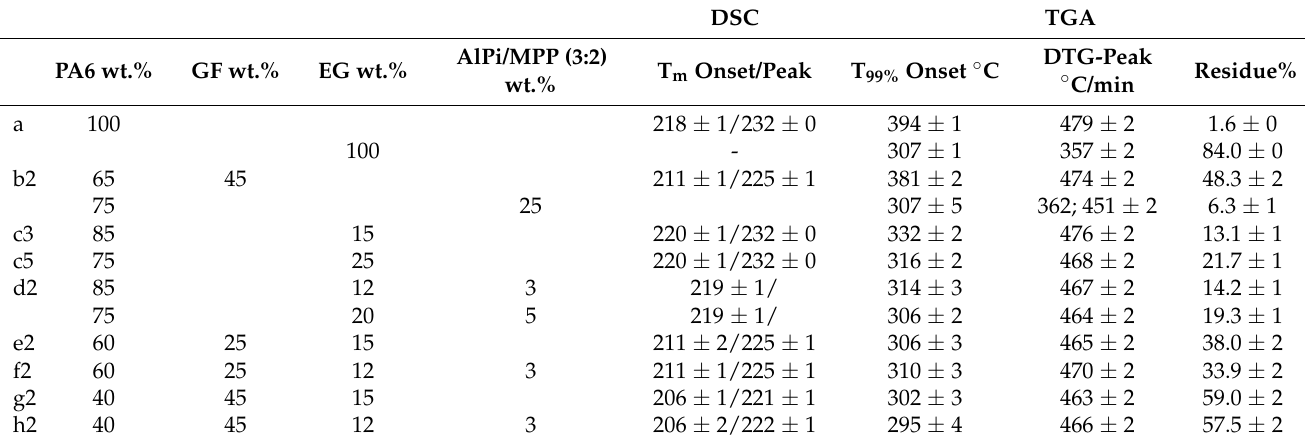
Table 1. TGA and DSC measurement results